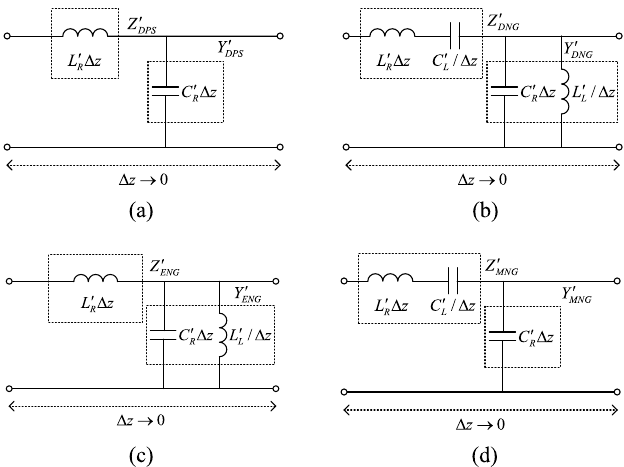
Fig. 1. In fi nitesimal equivalent circuits of lossless (a) DPS, (b) DNG, (c) ENG, and (d) MNG transmission lines.